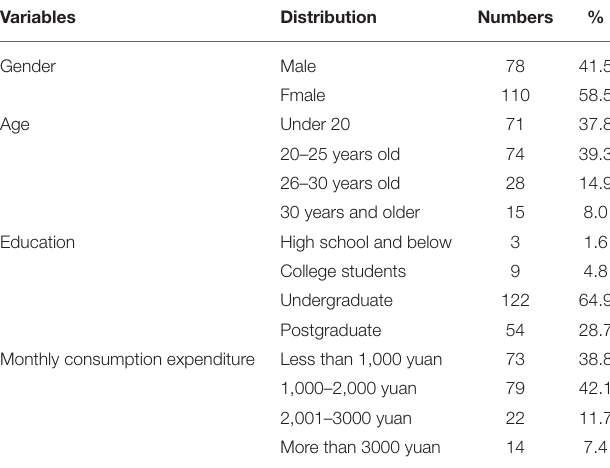
TABLE 2 | Demographic information of the participants in Experiment